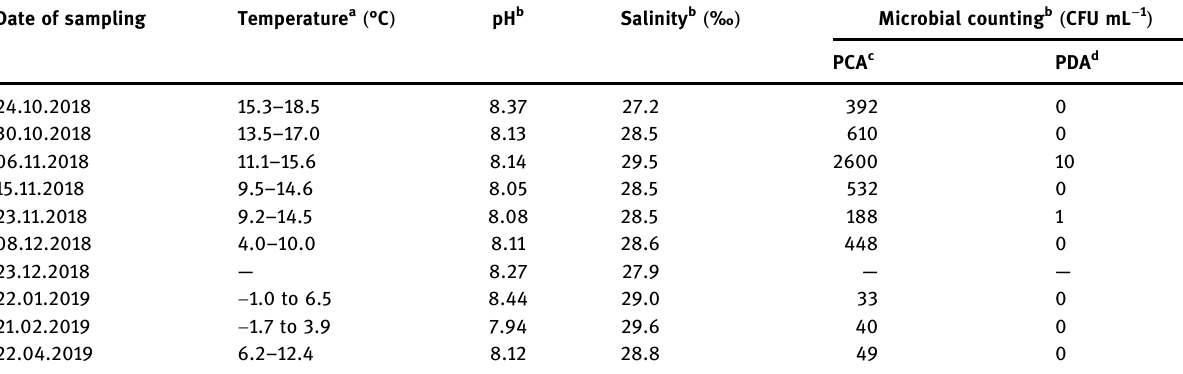
Table 1: Parameters of seawater in the Bohai Bay, China Date of